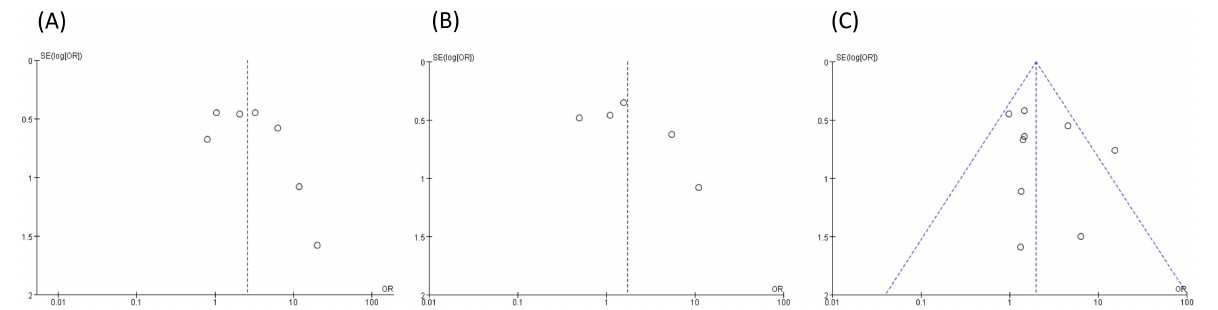
Figure 3. Funnel plot for publication bias of the included studies: ( A ) Neutropenia, ( B ) Leukopenia, and ( C )